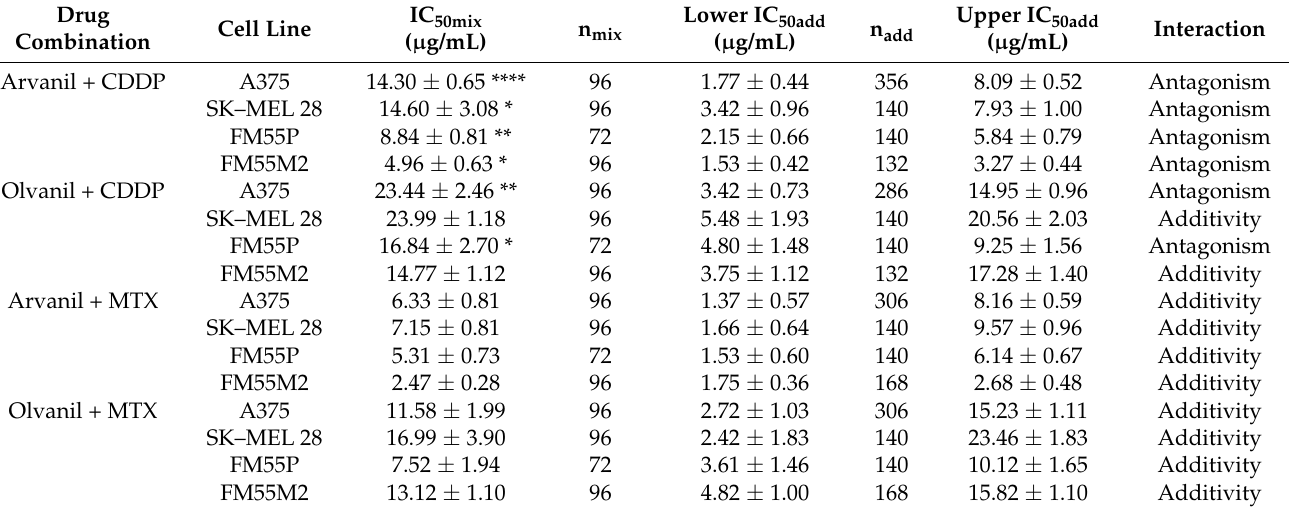
Table 2. Isobolographic analysis of interactions between arvanil, olvanil, CDDP, and MTX (at the fixed ratio of 1:1) in various melanoma malignant cell